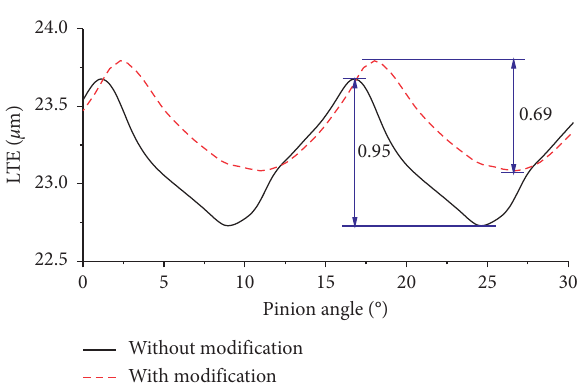
Figure 27: LTE of output-stage gear pair with and without modification.